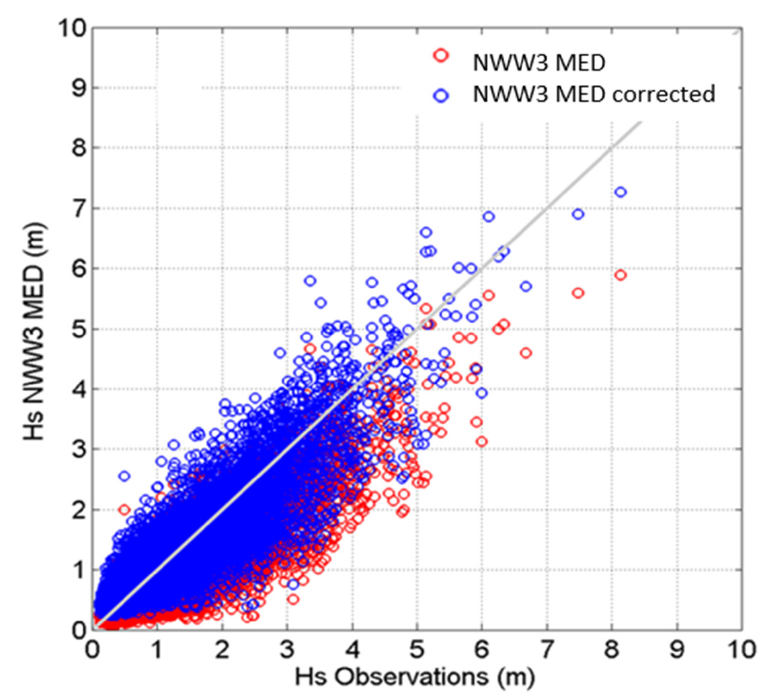
Figure A2. Observed and simulated Hs at the Cap Corse buoy, period 1999–2008.